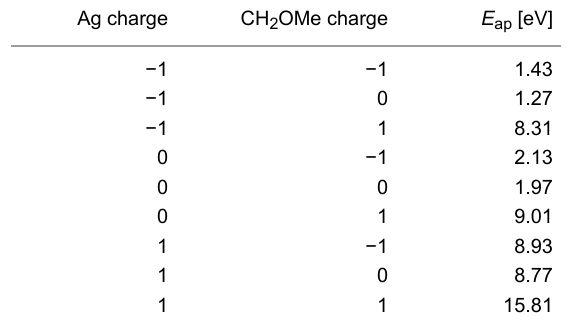
Table 8: Appearance energy (Equation 2) of differently charged Ag and CH 2 OMe fragments from dissociation of [AgCH 2 OMe]. Ag